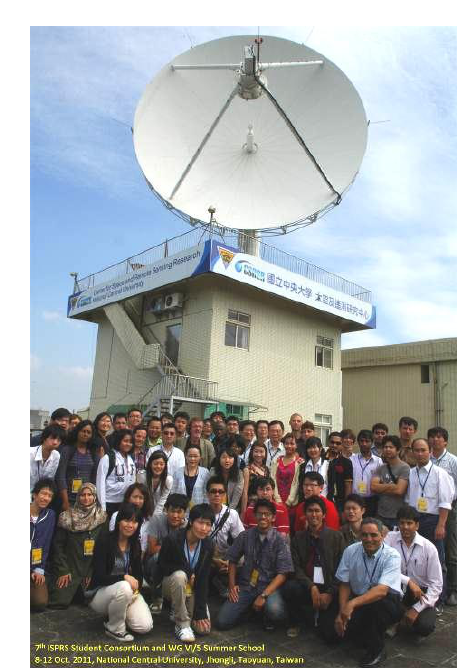
Figure 4. Group photo of ISPRS-SC Summer School 2011 in Taiwan